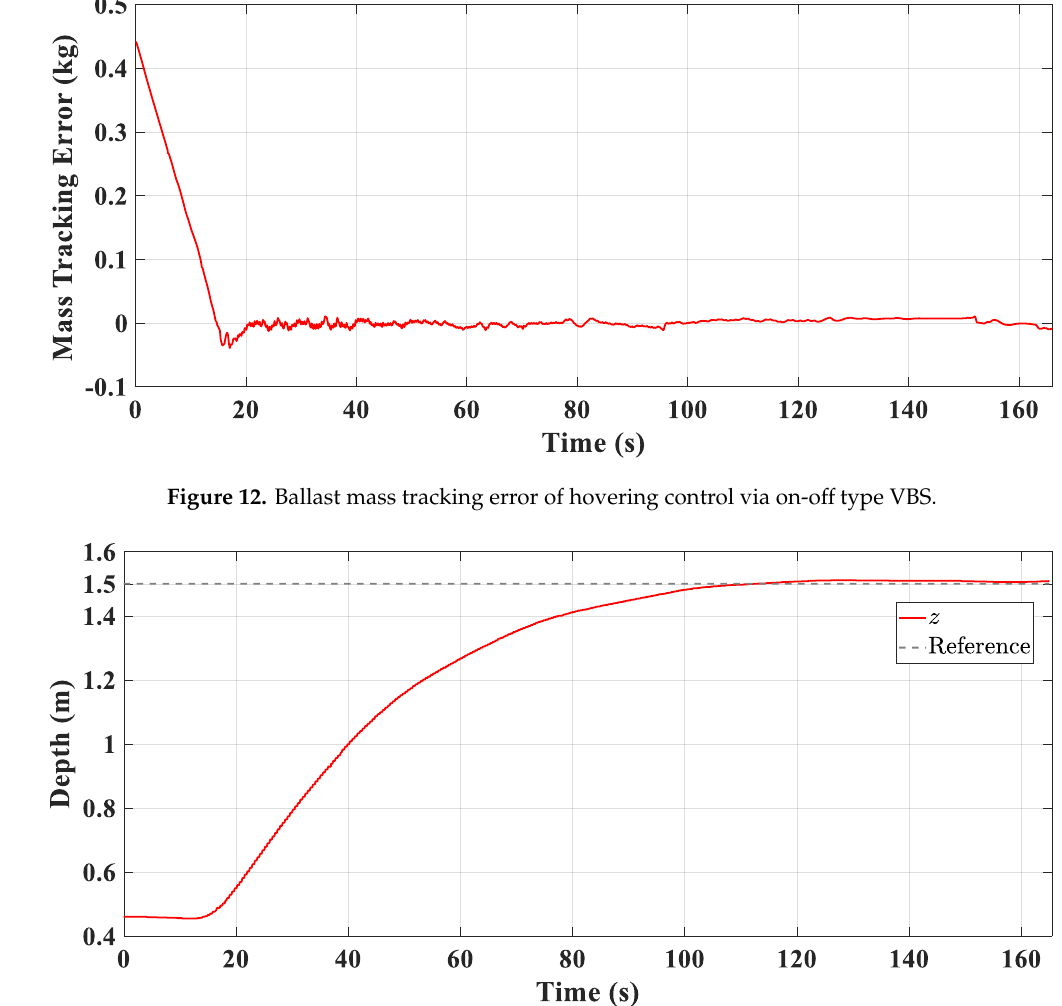
Figure 11. Demanded and actual ballast mass changes of hovering control via on-off type VBS.